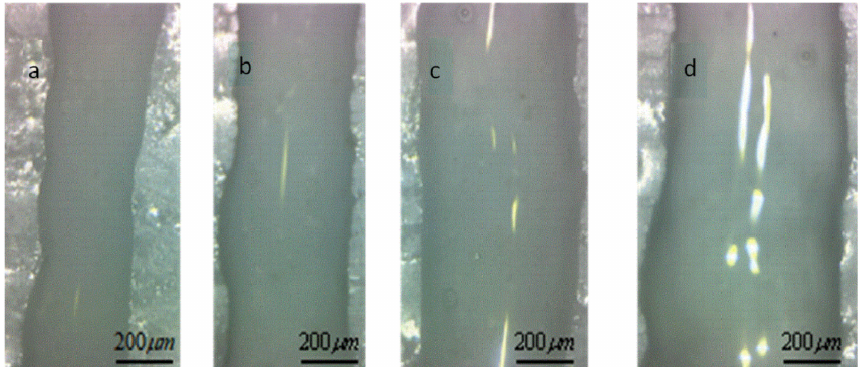
Figure 8. Extrusion line form at di ff erent pressure. ( a ) extrusion line with the feeding pressure is 1.5